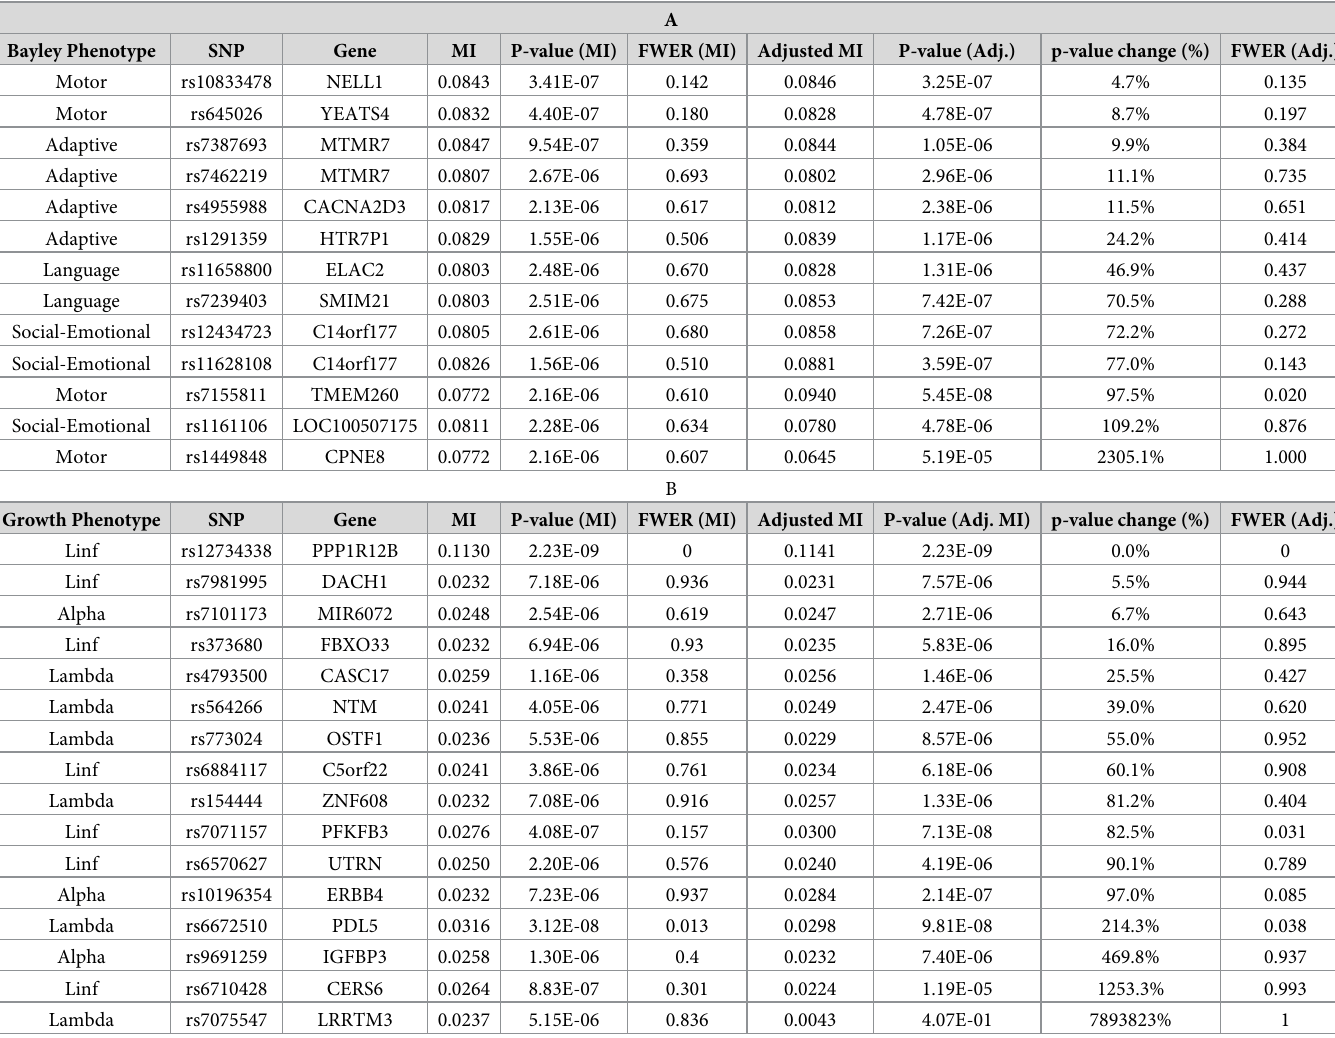
Table 11. Results for dependencies adjusted for the confounding effect of ethnicity. A. is for the Bayley phenotypes, and B is for the growth